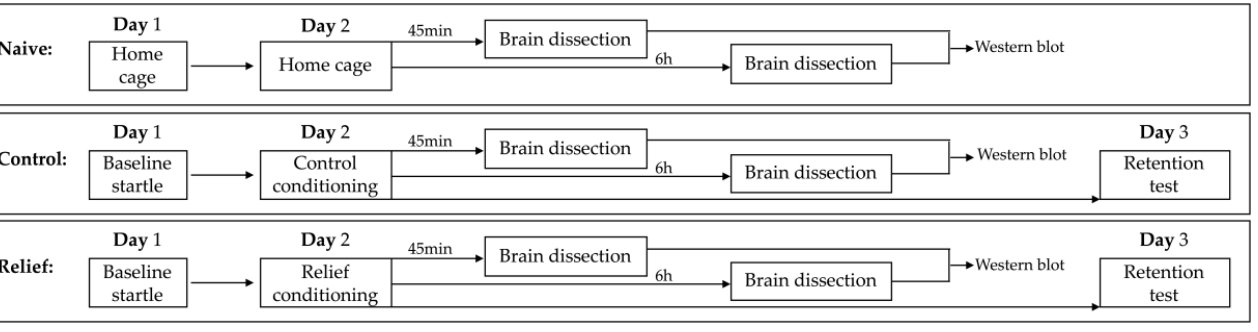
Figure 1. Experimental design overview.